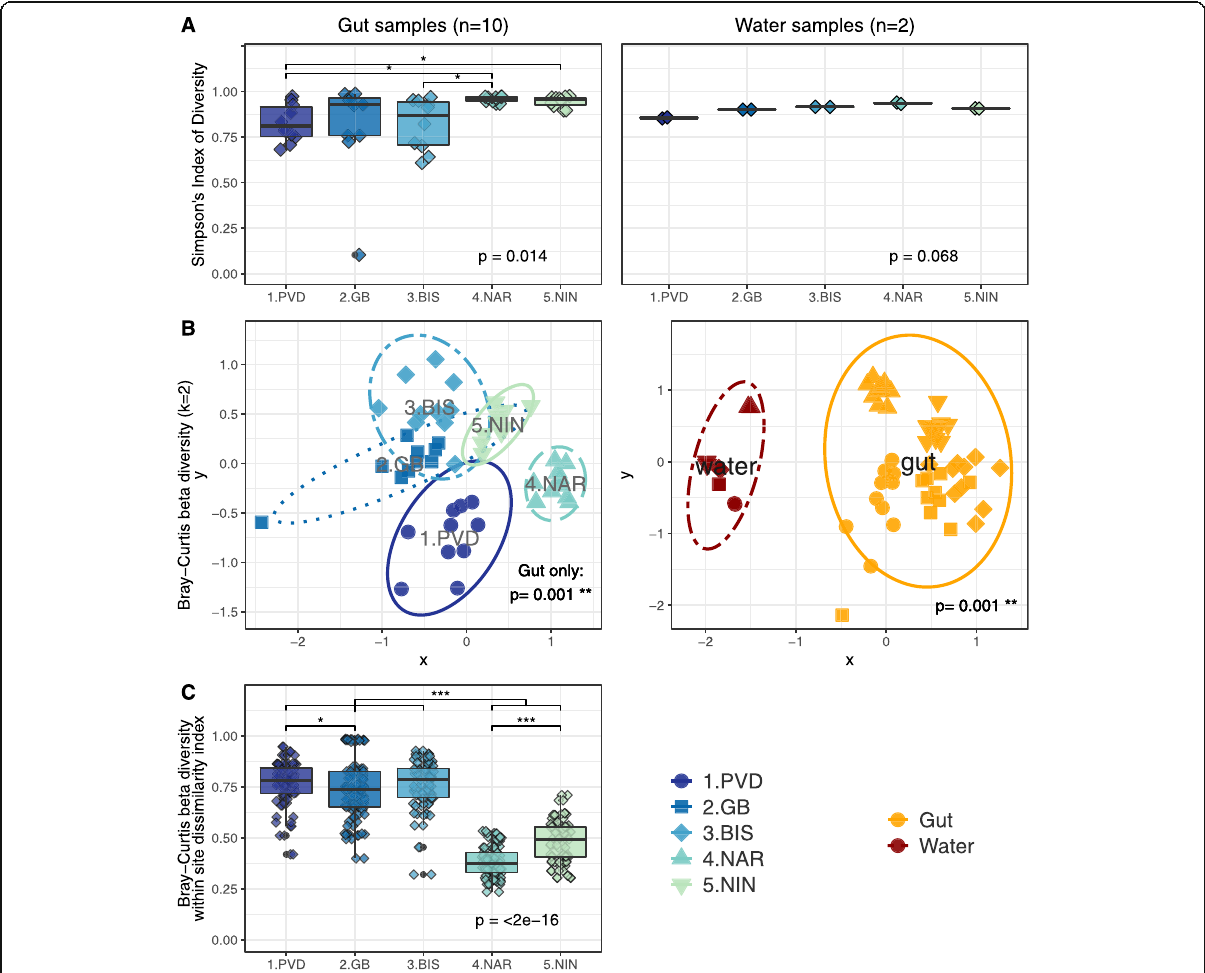
Fig. 3 Effect of site and sample type on diversity indices in present bacterial community structures. a Simpson ’ s Index of Diversity calculated using ASV-level 16S rRNA gene amplicons for gut samples (left, n = 10) and water samples (right, n = 2). Global p -values were calculated using the Kruskal-Wallis rank-sum test, and pairwise p -values were calculated with the Wilcox rank-sum test. b NMDS plot visualization of Bray-Curtis beta- diversity (k = 2) at the ASV level for gut samples by Site (left) and all samples by Type (right). The ellipse lines show the 95% confidence interval (standard deviation). p -values indicate significance of grouping with adonis2 Permutational Multivariate Analysis of Variance Using